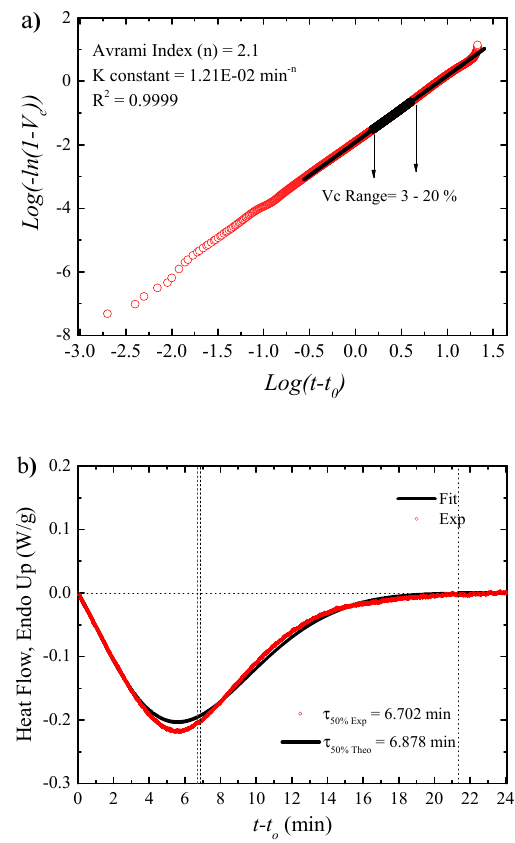
Figure 9. Isothermal crystallization studied by DSC. ( a , b ) Avrami plot and raw heat flow data obtained during crystallization of PA6 at 192 °C, compared to the data predicted by the Avrami model.